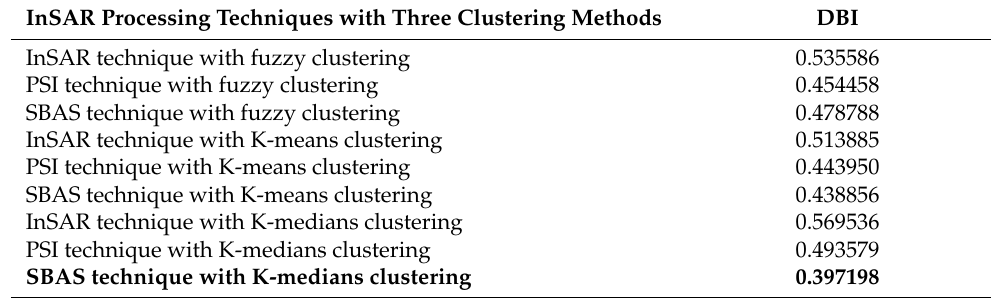
InSAR Processing Techniques with Three Clustering Methods